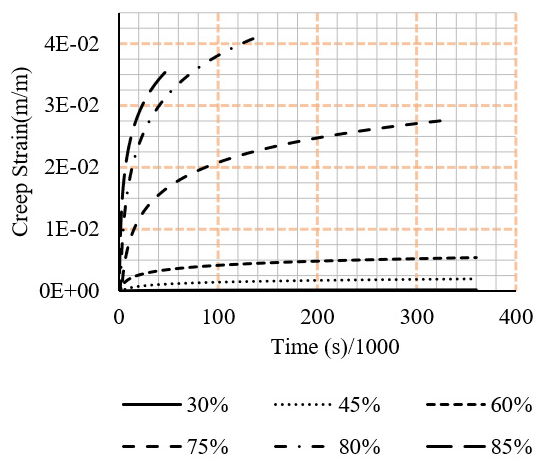
Figure 6. Compressive creep data from the experimental testing under different loading rations (ratio of sustained load to the ultimate load).